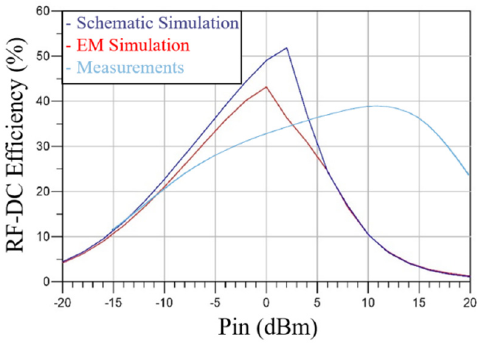
Figure 12. Simulated RF–DC converter circuit efficiency results.